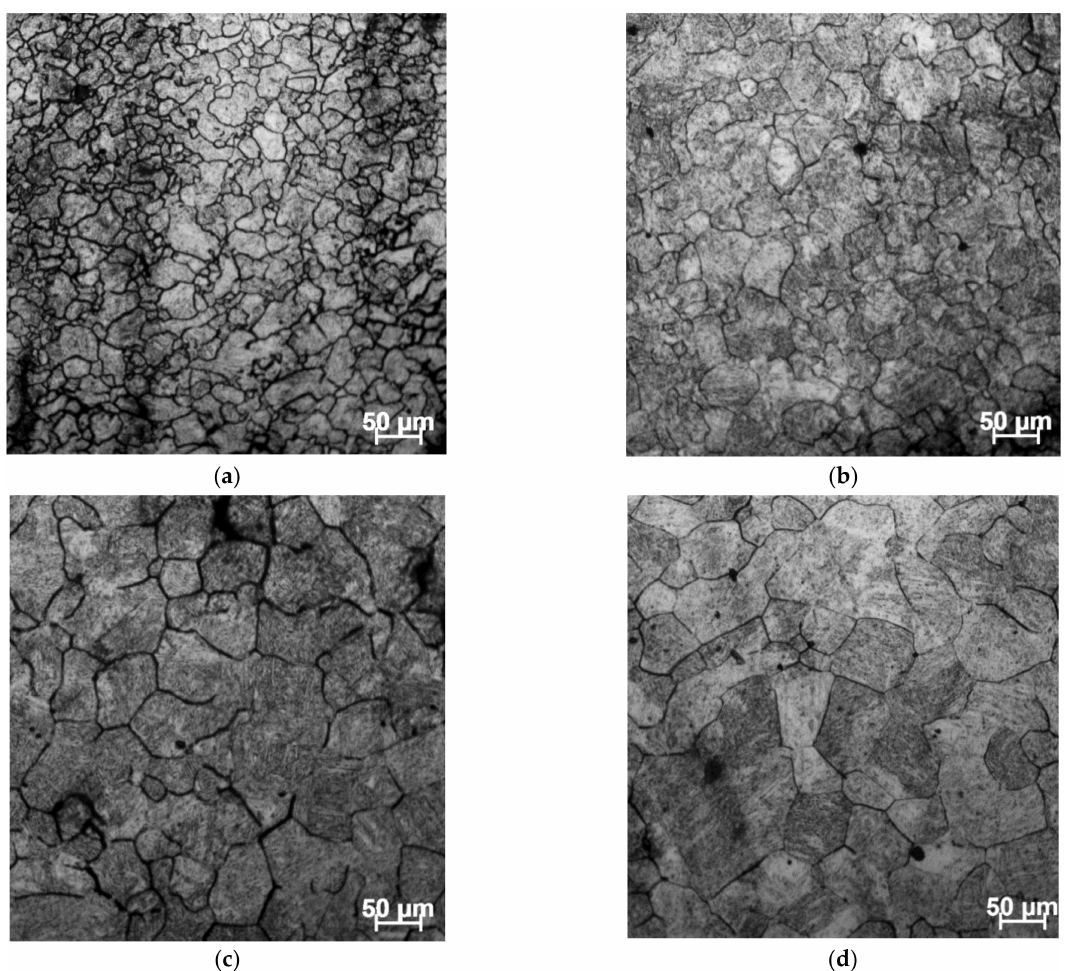
Figure 12. Optical microstructures of SAE 5137H steel in stable domains, a fix strain rates of 0.1 s − 1 and different temperature: ( a ) 1213 K; ( b ) 1303 K; ( c ) 1393 K; and ( d ) 1483